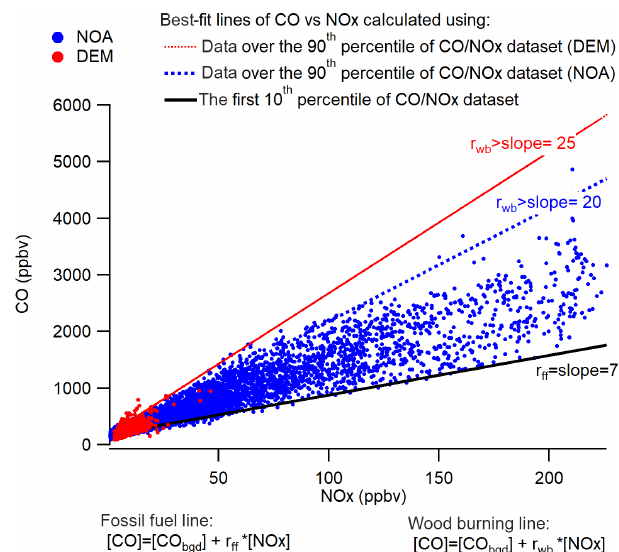
Figure 11. Scatter plot for CO and NO x data from NOA (blue) and DEM (red) along with best-fit lines, aligned in the lower edge of CO versus NO x scatter charts (black), and in the upper edge (blue and red for NOA and DEM,